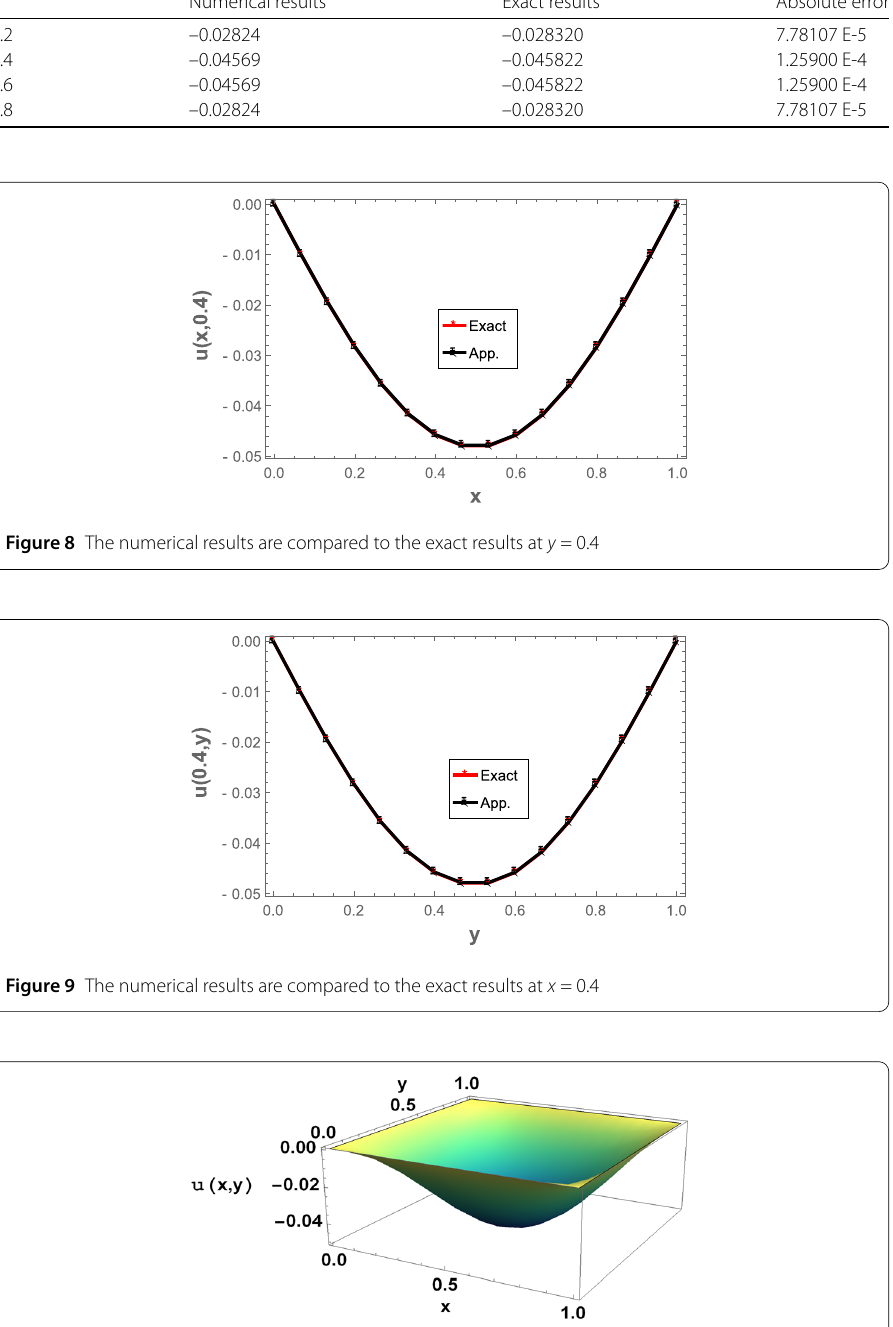
Figure 10 Three-dimensional graph of numerical results